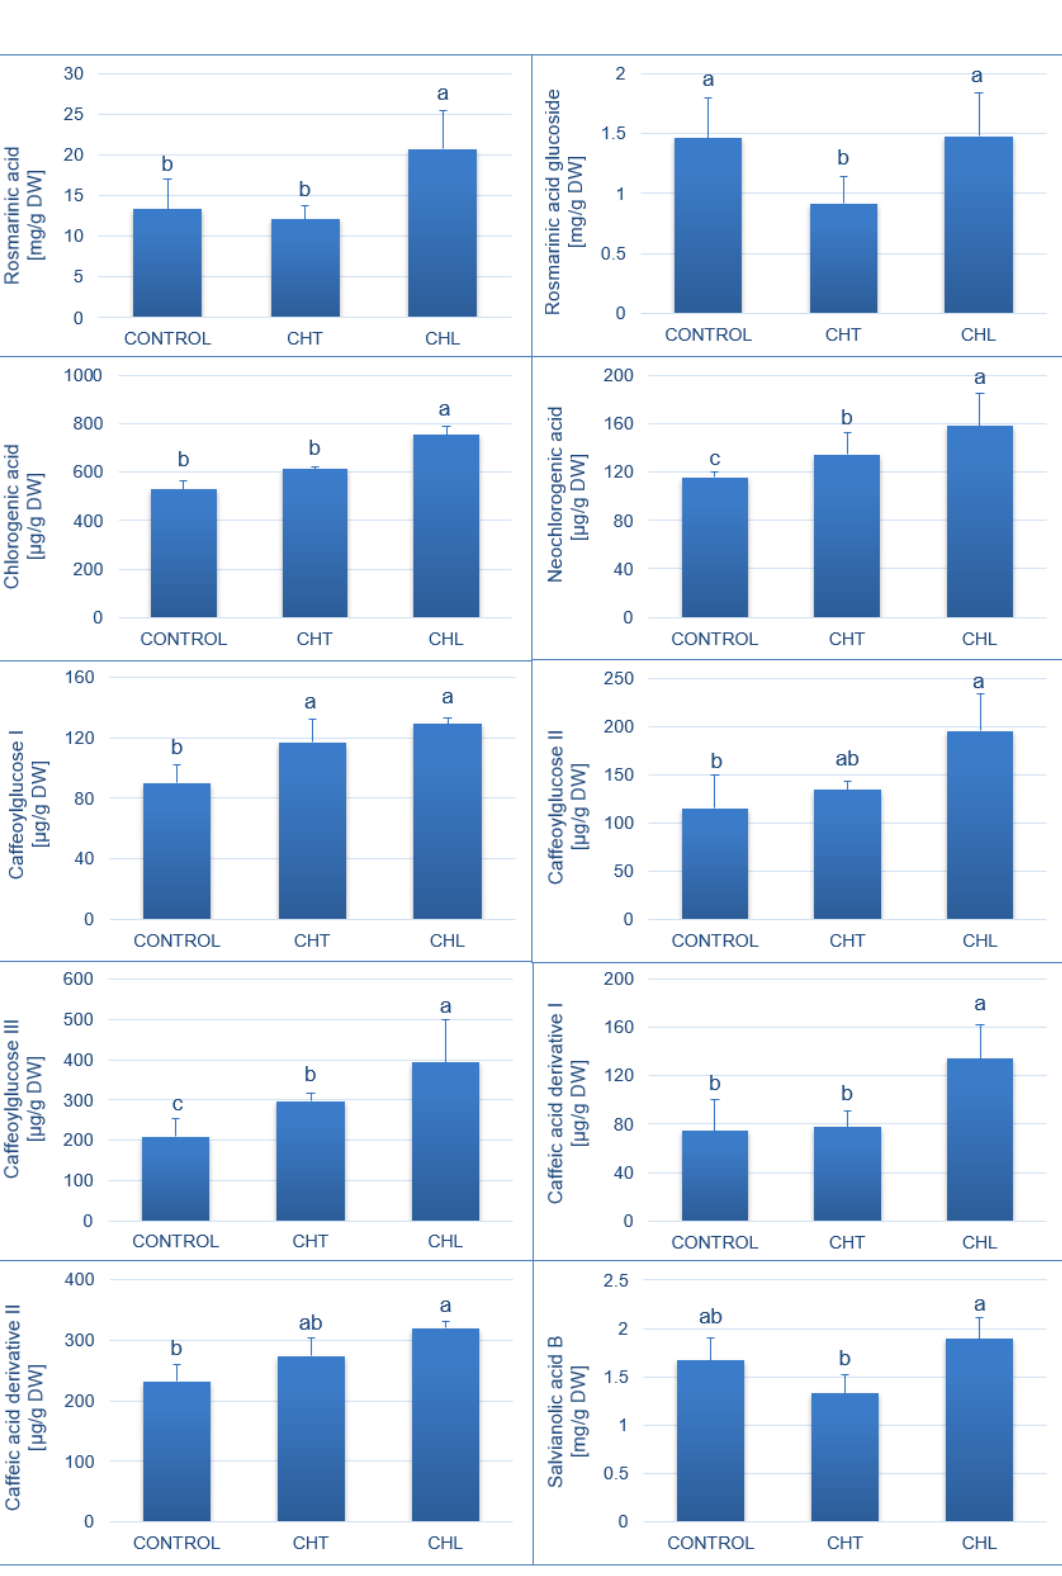
Figure 3. Content of selected phenolic compounds in P. amboinicus leaf extracts, depending on the form of chitosan used in the solutions for spraying the plants (CHT—chitosan suspension; CHL— chitosan lactate). Mean values (±standard deviation; n = 3) marked with different letters were statistically significantly different ( p < 0.05).